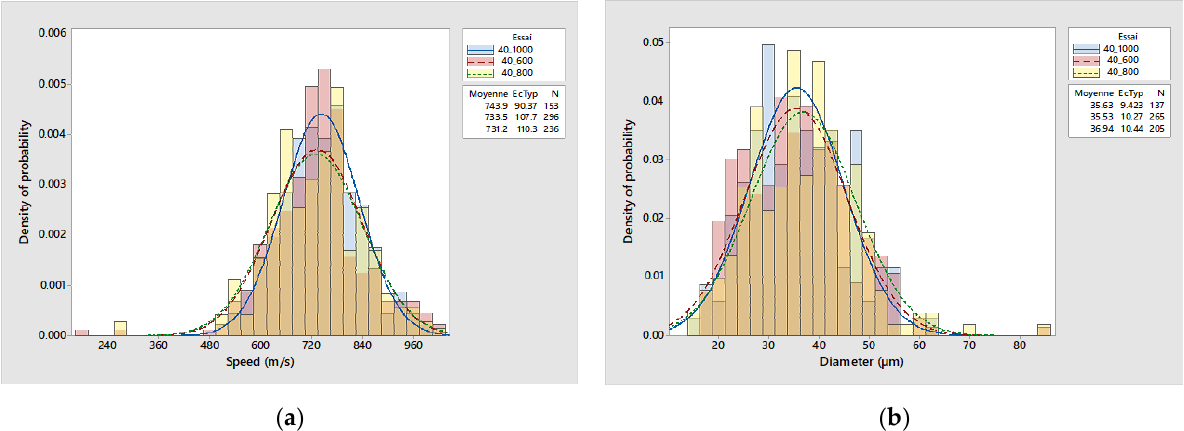
Figure 5. ( a ) Ti 3 AlC 2 particle velocities distribution; ( b ) the corresponding particle density distribution a constant gas pressure of 4 MPa and different gas temperatures.